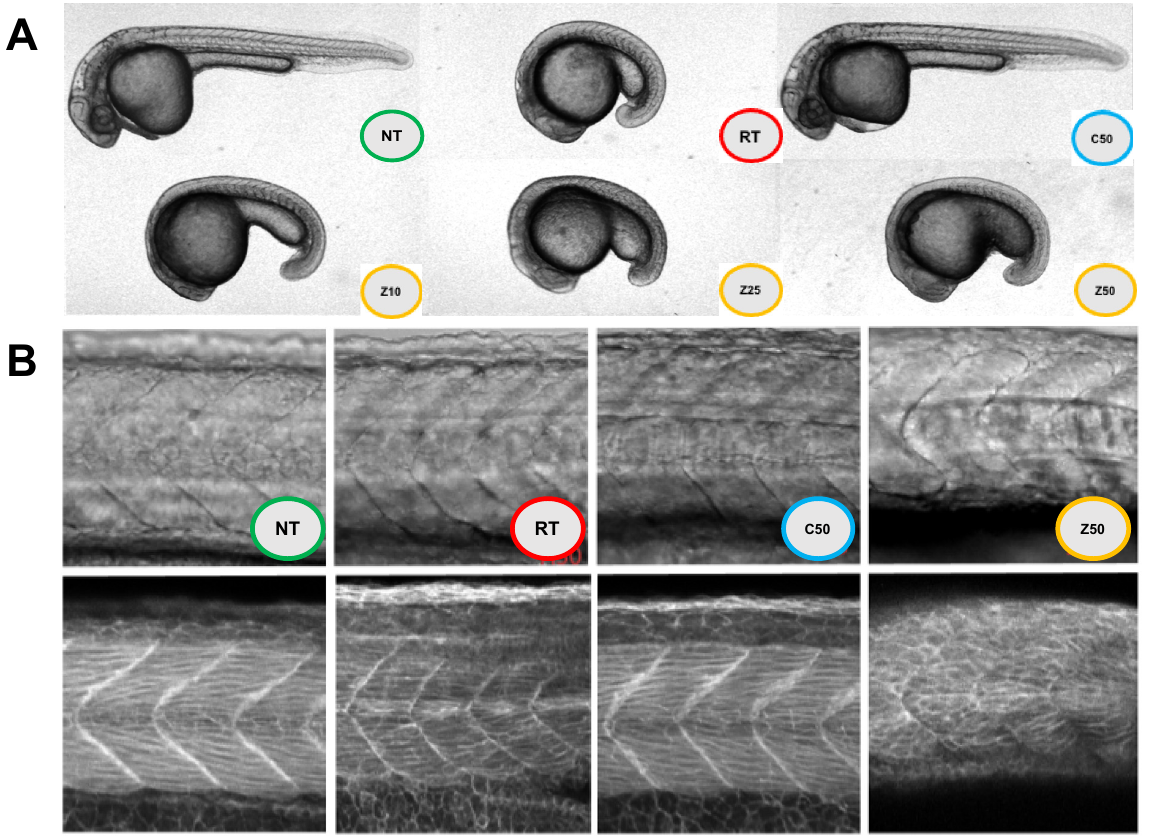
Figure 4. MBP-zfCC11A, in vivo. MBP-zfCC11A was the reagent selected to validate the use of chimeric CLDNs to observe its effects in vivo . Zebrafish embryos treated at 12 hpf, imaged at 21 hpf. Images taken with 20× lens at 3× zoom. Panel ( A ), Zebrafish embryos. NT , no treatment; RT , embryos maintained at room temperature; C50 , 50 μ g of MBP-2jua as control; Z10, Z25, Z50 , 10, 25 or 50 μ g/mL of MBP-zfCC11A. Panel ( B ), qualitative analysis of somite development. NT , no treatment; RT , embryos maintained at room temperature; C50 , 50 μ g of 2jua as control; Z50 , 50 μ g of zfCC11A.